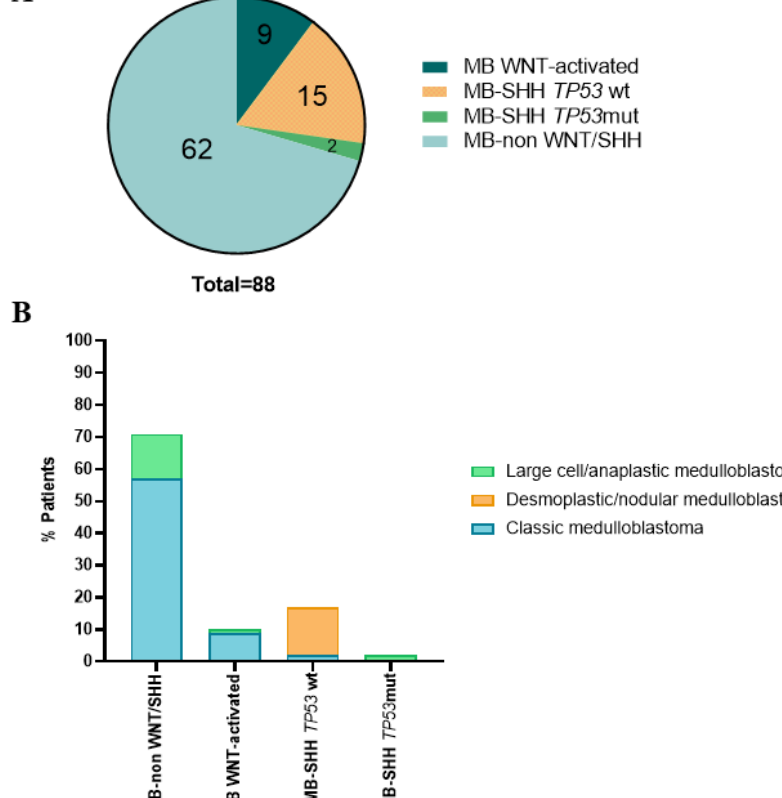
Figure 1. Molecular groups of pediatric medulloblastomas. ( A ): Non-WNT/SHH group are more than 60 cases of the cohort (62/88), Group SHH TP53 wt are 15 cases (15/88), Group WNT-activated 9 cases (9/88) and Group SHH TP53 mut, 2 cases (2/88). ( B ): The four groups showed differences in histological distributions.